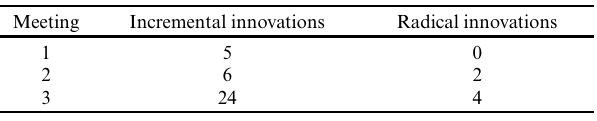
Table 2 . Supportive discussions around incremental and radical innovations, over